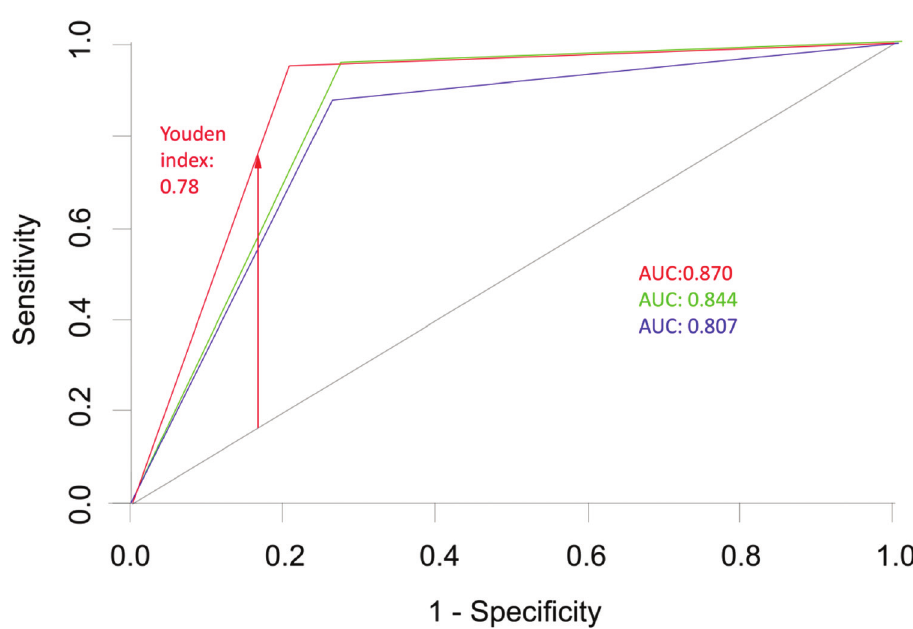
Figure 2 - ROC curves expressing the ability of ODI to distinguish between patients with mild and moderate apnea (curve 1 – blue), between patients with moderate and severe apnea (curve 2 – green), and between patients with mild or no apnea and patients with moderate and severe apnea (AHI 4 15 cut-off, curve 3 – red). ROC: receiver operating characteristics; AUC: area under the curve; AHI: apnea-hypopnea index; ODI: oxyhemoglobin desaturation